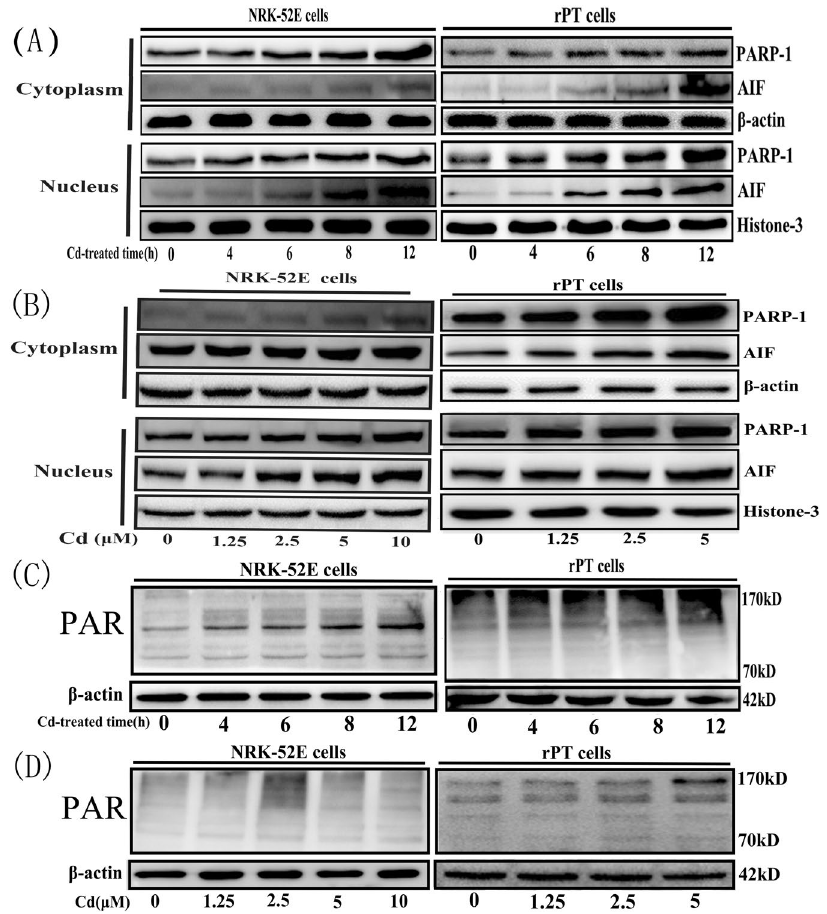
Figure 2. Changes of parthanatos-related proteins caused by cadmium. Western blot analysis of the expression of parthanatos-related proteins in NRK-52E cells and primary rPT cells after treated with different concentrations of Cd for 12 h. ( A and B ) Cytoplasmic and nuclear PARP-1 and nuclear AIF increased as the Cd concentration and incubation time increased in NRK-52E cells and primary rPT cells. ( C and D ) Cd induced the cytoplasmic formation of PAR polymer, dependent on its concentration and exposure time in NRK-52E cells and primary rPT